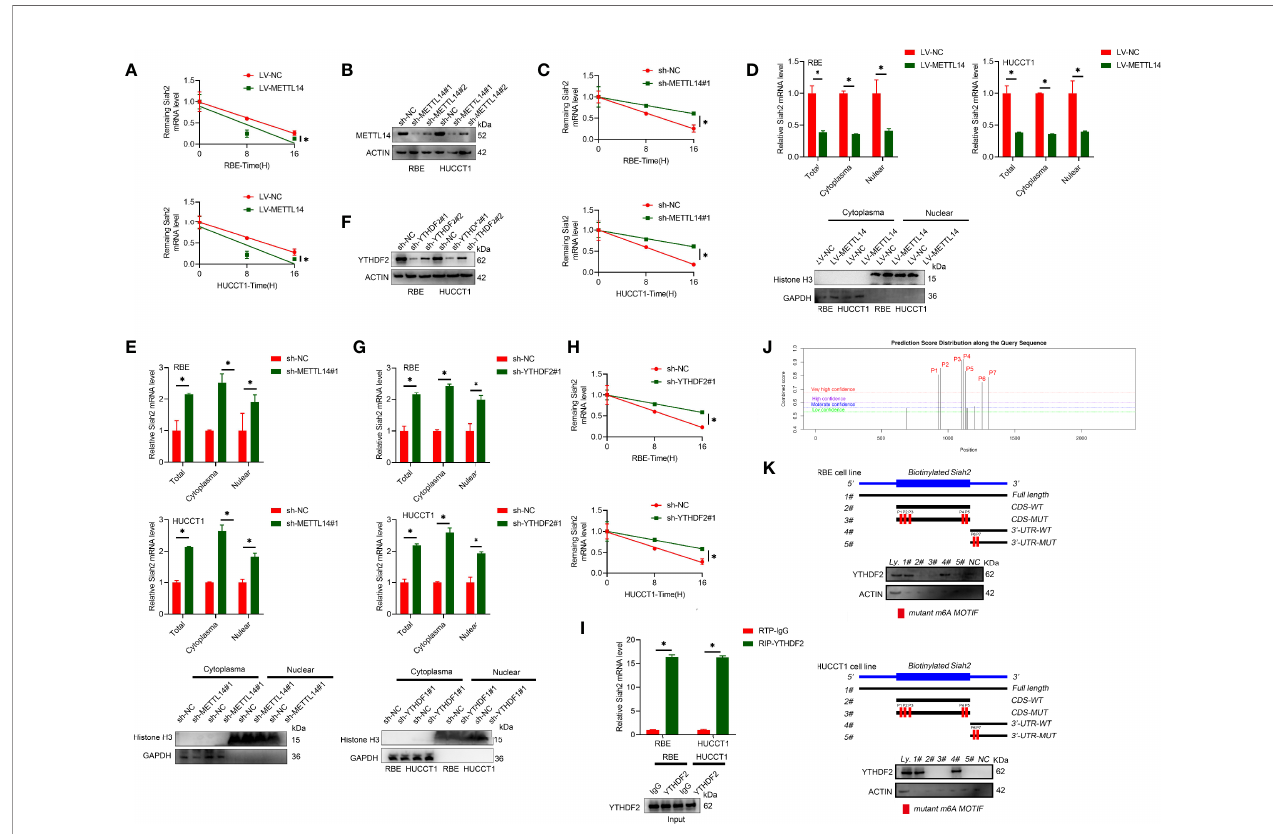
FIGURE 2 | METTL14 promotes Siah2 mRNA degradation in CCA. (A) , The stability of Siah2 mRNA in CCA cells with LV-NV or LV-METTL14 was detected by quantitative RT-PCR upon actinomycin D 10 mg/ml treatment. (B) , Western blot analysis for METTL14 expression in CCA cell lines with stable METTL14 knockdown. (C) , The stability of Siah2 mRNA in CCA cells with sh-NC or sh-METTL14 was detected by quantitative RT-PCR upon 10 mg/mL actinomycin D treatment. (D, E) , Quanti fi cation of Siah2 mRNA level in total, nuclear, and cytoplasmic fractions by quantitative RT-PCR in CCA cells. Nuclear and cytoplasmic fractions were evaluated by Western blot analysis. (F) , The successful knockdown of YTHDF2 in CCA cells was con fi rmed by Western blot analysis. (G) , The expression of Siah2 mRNA was detected by quantitative RT-PCR in CCA cells transfected with sh-NC or sh-YTHDF2. (H) ,The stability of Siah2 mRNA was detected by quantitative RT-PCR in CCA cells transfected with sh-NC or sh-YTHDF2 upon 10 mg/mL actinomycin D treatment. (I) ,RNA immunoprecipitation assay detected the interaction between YTHDF2 and RNA in CCA cells. RNA enrichment was measured by quantitative RT-PCR. RIP with non-speci fi c IgG was set as